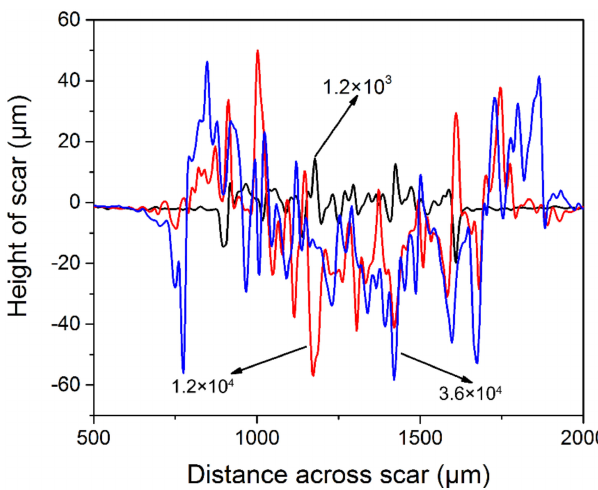
Figure 4. The typical cross-sectional profile of worn scars of alloy 690TT after the cycle numbers of 1.2 × 10 3 , 1.2 × 10 4 , and 3.6 × 10 4 .